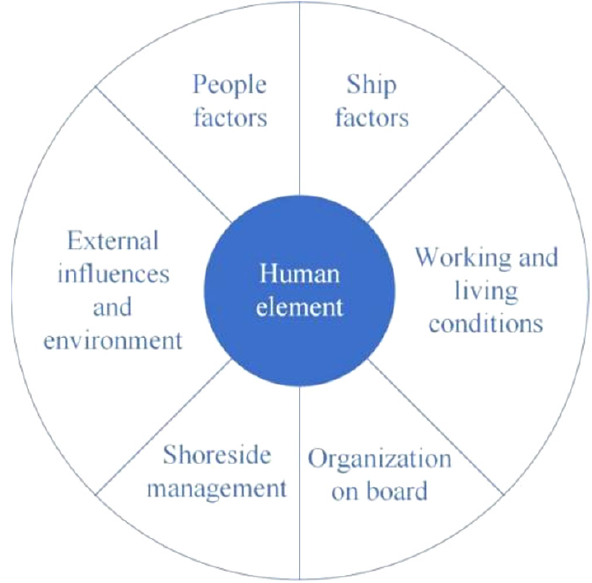
Figure 3. The “human element” and its components.